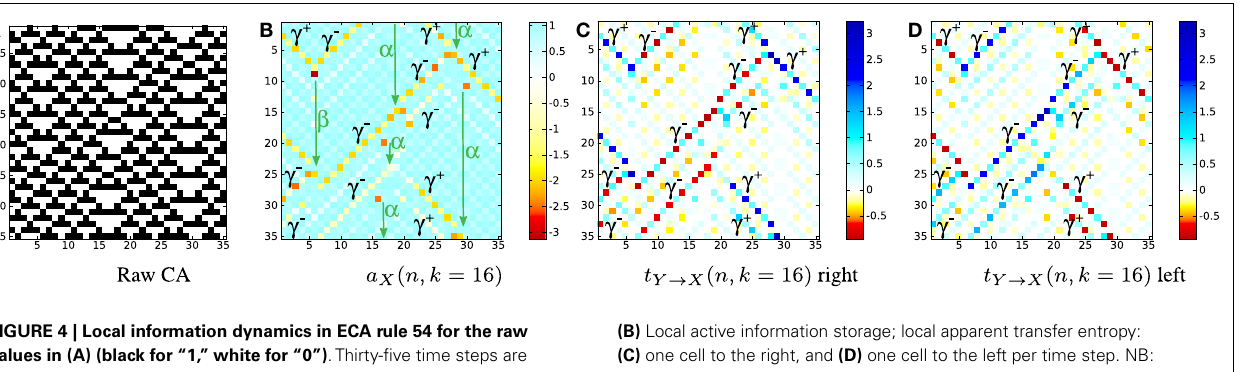
(B) Local active information storage; local apparent transfer entropy: (C) one cell to the right, and (D) one cell to the left per time step. NB: Reprinted with kind permission of Springer Science + Business Media from Lizier